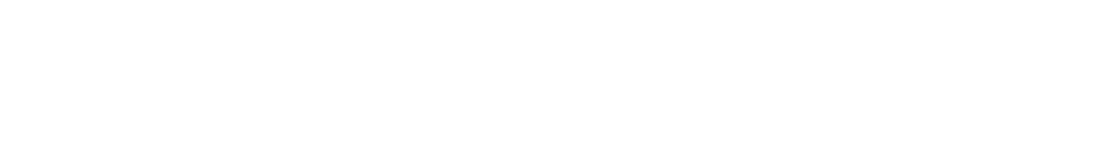
Frontiers in Energy Research |